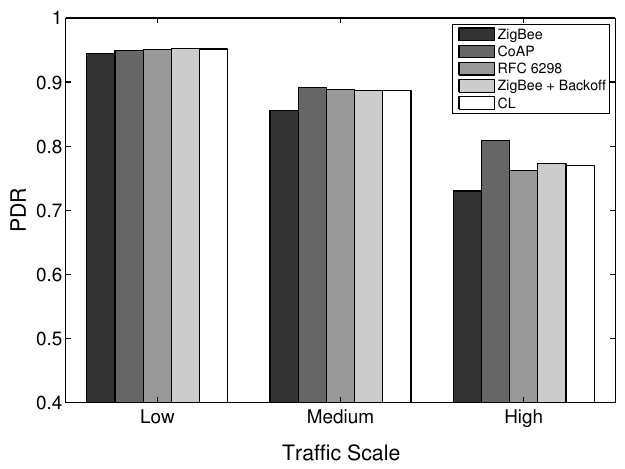
Figure 16. PDR results for different RTO